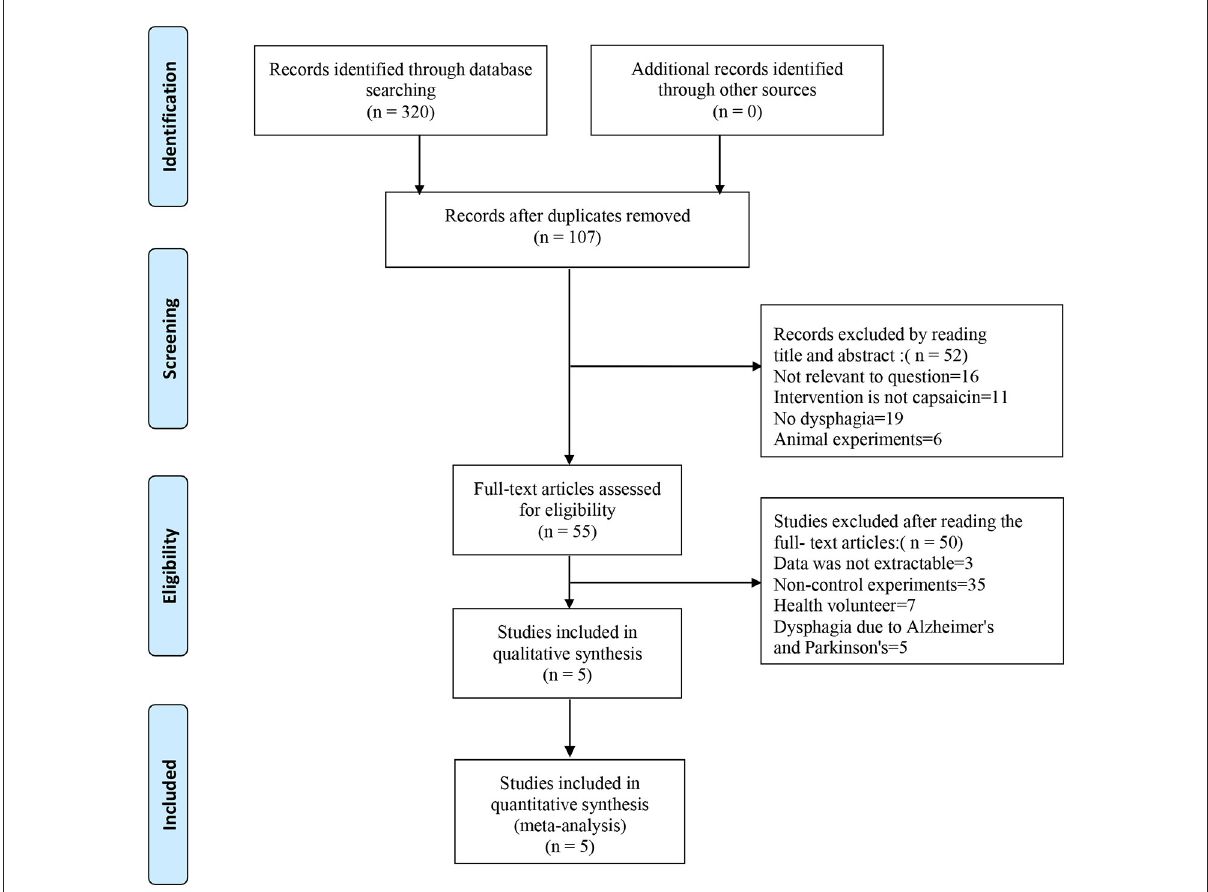
FIGURE1 Flowchart of study selection.